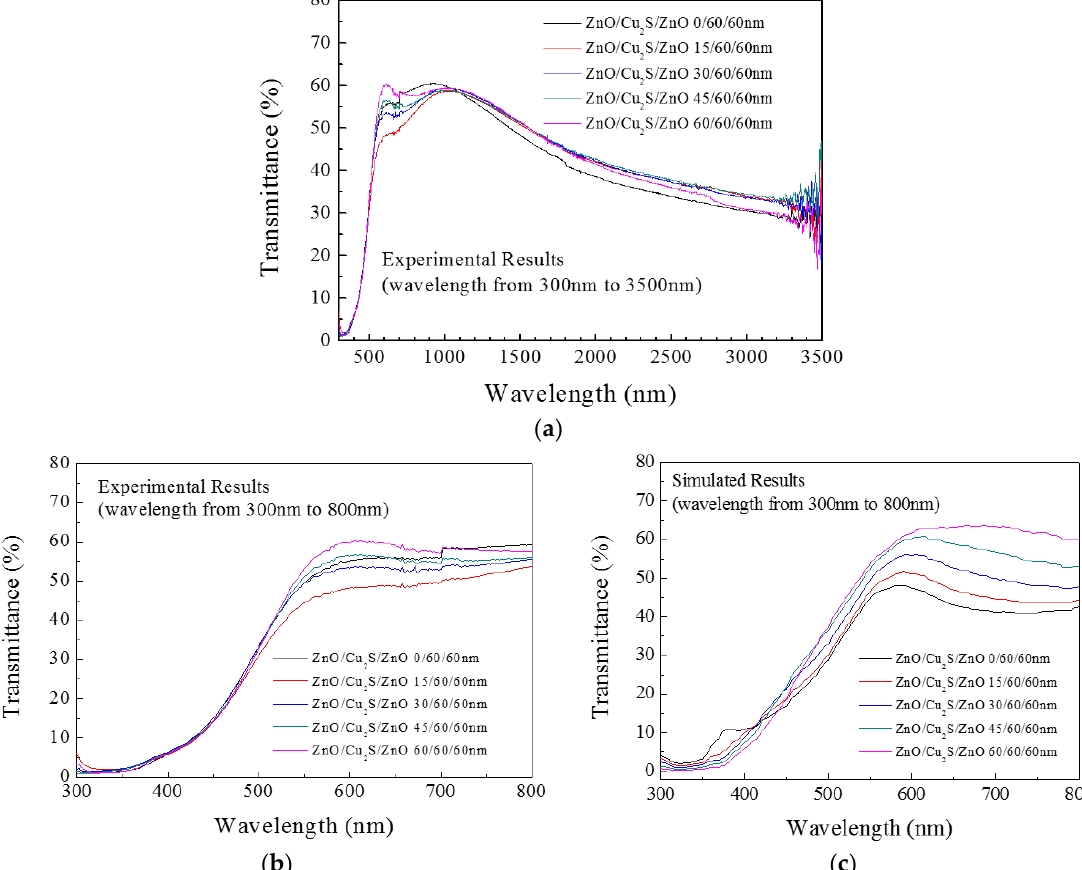
Figure 24. The ( a , b ) experimental and ( c ) simulation transmittance results of ZnO/Cu 2 S/ZnO/glass complex films for different thickness.